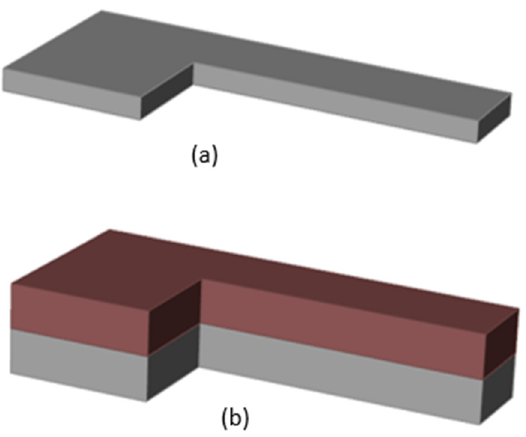
Figure 8. Design domains arrangement: ( a ) design domain before AM and ( b ) additive manufacturing design domain.